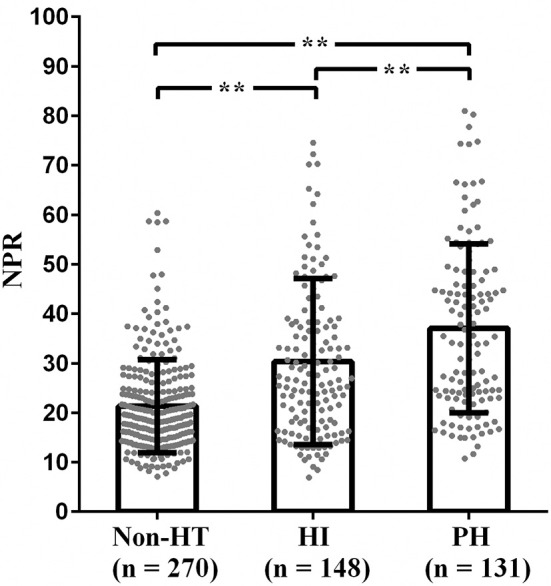
The levels of NPR in the subcategorized groups of HT. (1) The NPR was higher in patients with HI than those with non-HT [26.6 (17.9–38.3) vs. 19.1 (14.8–24.8), P < 0.001]; (2) The NPR was higher in patients with PH than those with non-HT [36.8 (23.7–49.2) vs. 19.1 (14.8–24.8), P < 0.001]; (3) The NPR was higher in patients with PH than those with HI [36.8 (23.7–49.2) vs. 26.6 (17.9–38.3)], P < 0.001). NPR, neutrophil-to-platelet ratio; HT, hemorrhagic transformation; HI, hemorrhagic infarct; PH, parenchymal hematoma; **P < 0.001.